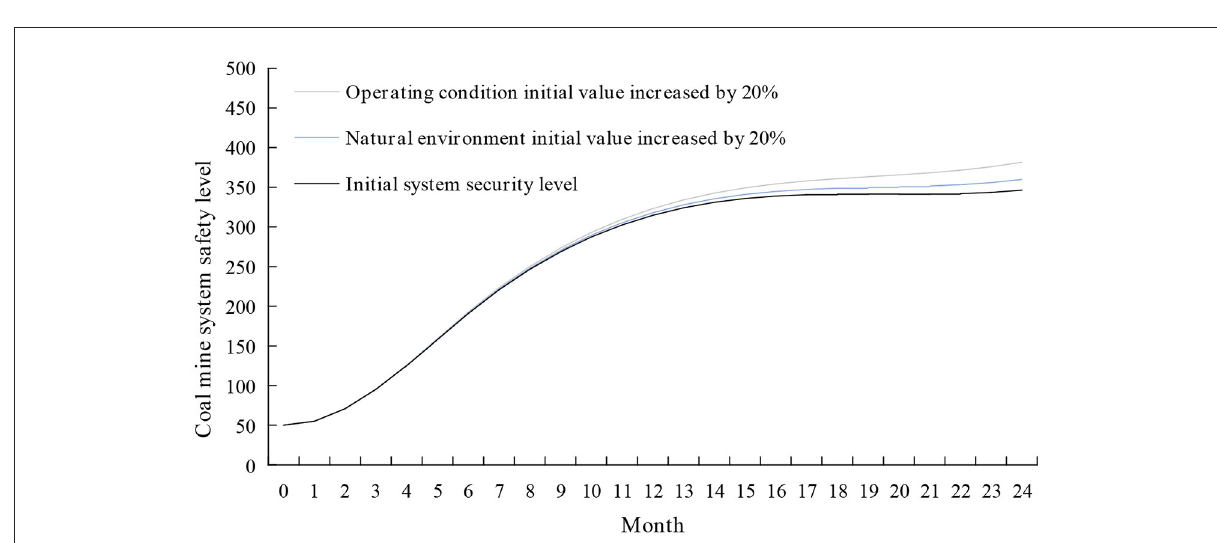
FIGURE12 Simulation results of coal mine system safety after the intervention of external environment